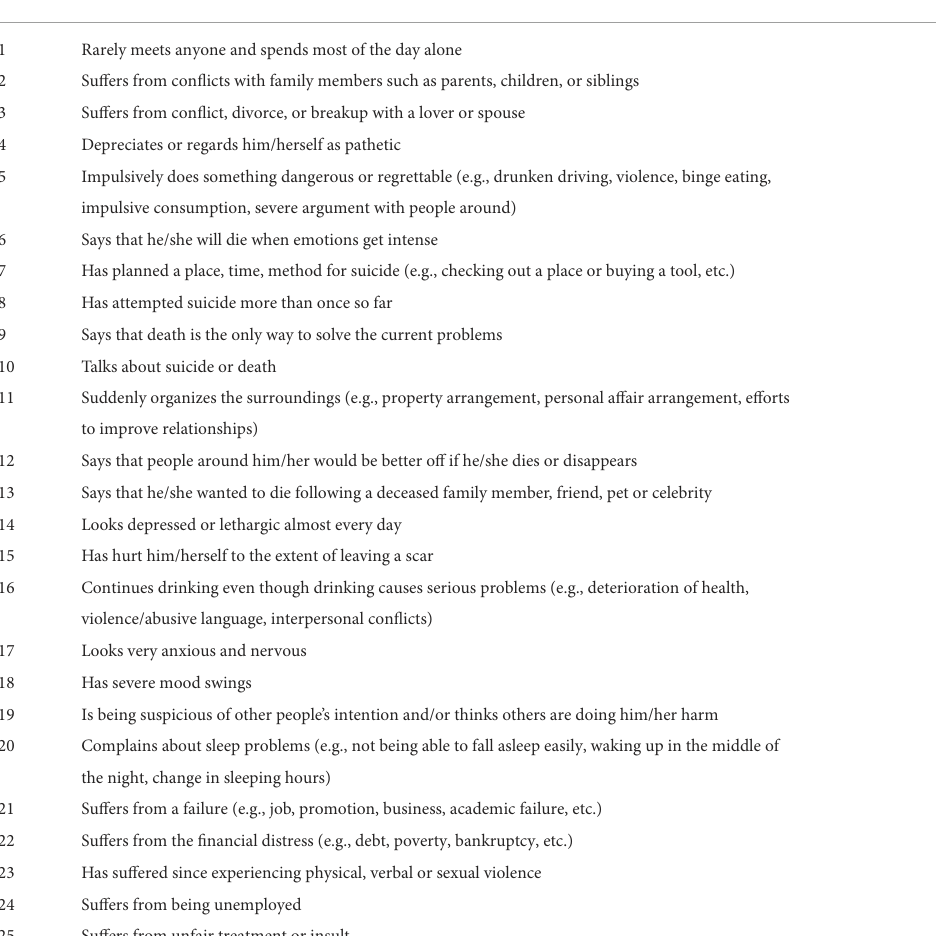
TABLE 5 Suicide screening questionnaire-observer rating; SSQ-OR. Content Yes No Do not